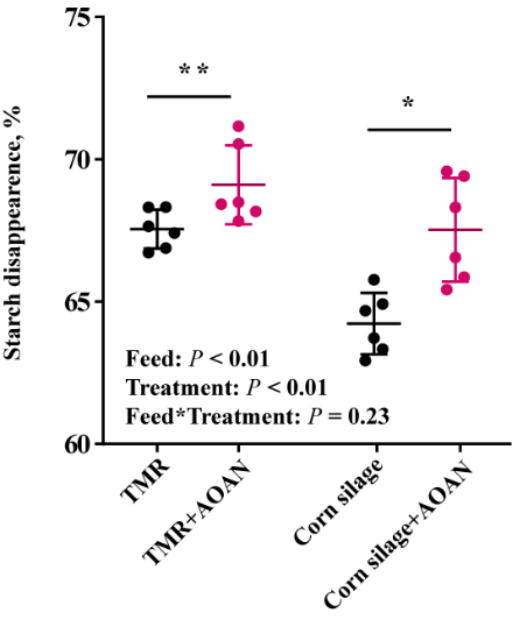
Figure 3. Effects of Aspergillus oryzae and Aspergillus niger co-cultivation fermentation extract on starch disappearance in total mixed ration and corn silage at 7 h in vitro incubation. AOAN indi- cates fermentation with Aspergillus oryzae and Aspergillus niger co-cultivation fermentation extract. *, p < 0.05; **, 0.05 < p < 0.1; TMR, total mixed ration.